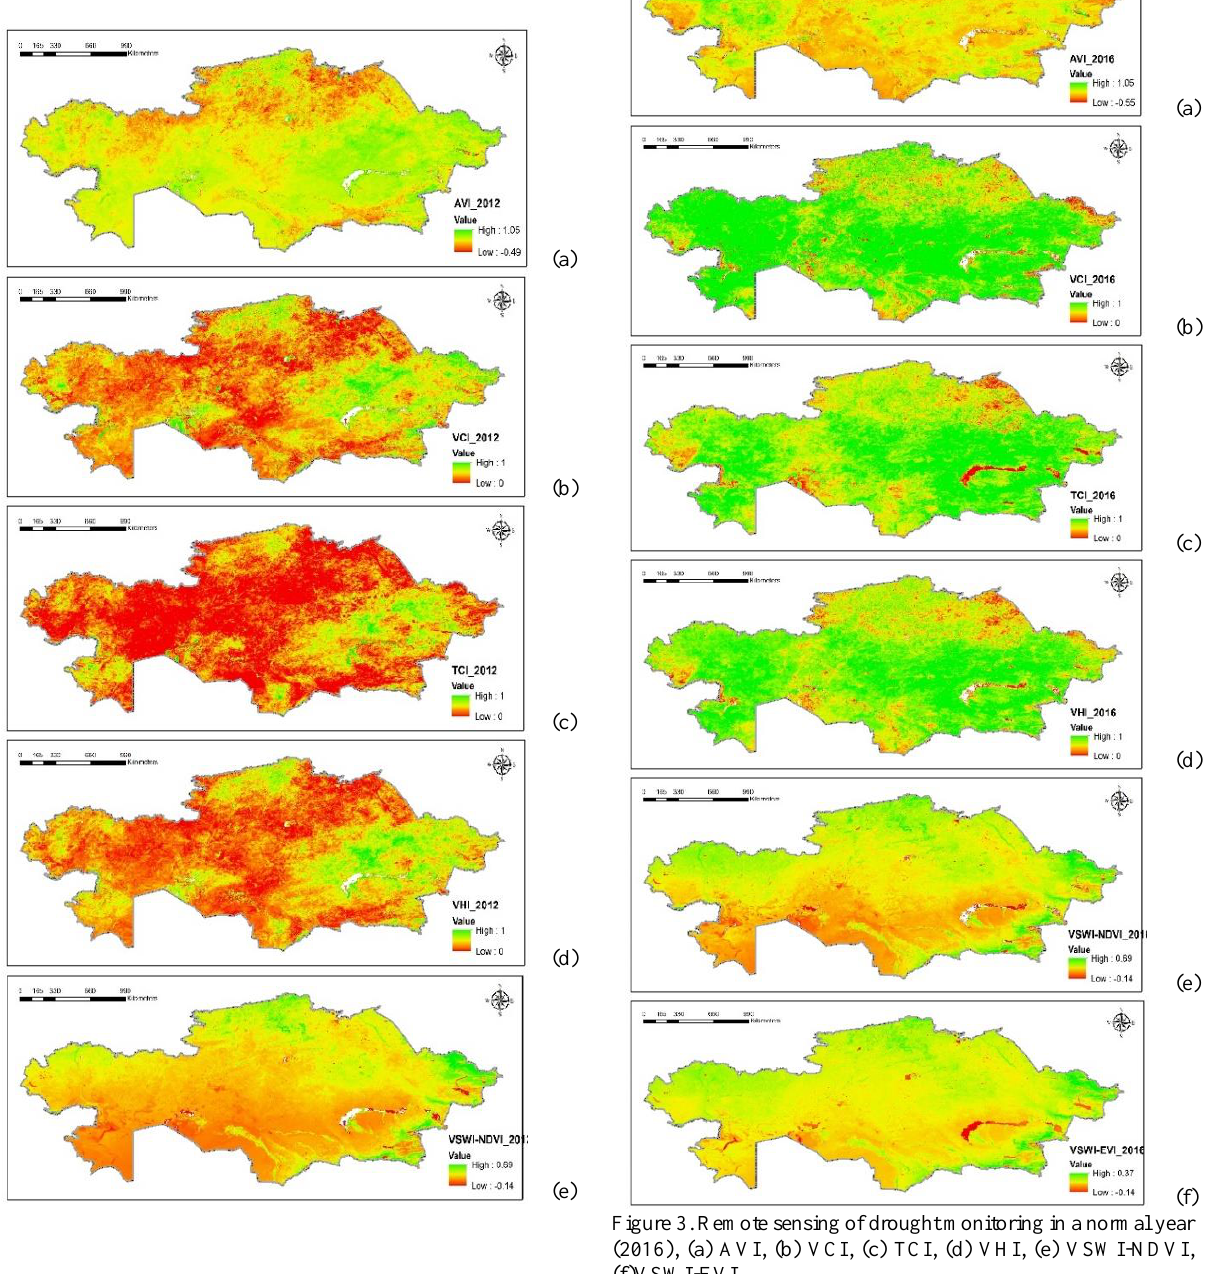
Figure 3. Remote sensing of drought monitoring in a normal